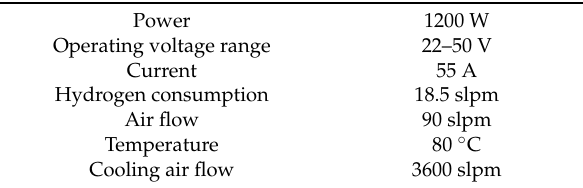
Table 1. Maximum characteristics of Nexa 1200 fuel cell.